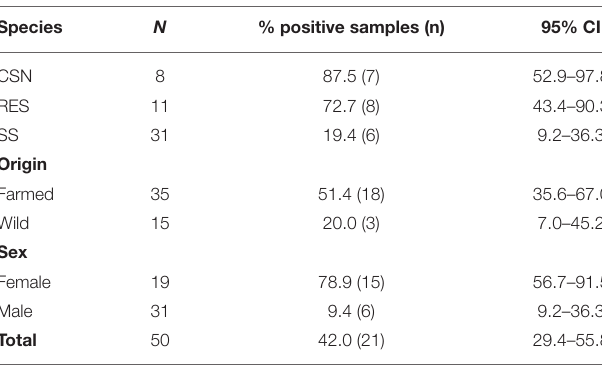
TABLE 1 | The total number and proportion of turtles positive for Salmonella enterica by species, origin and sex.